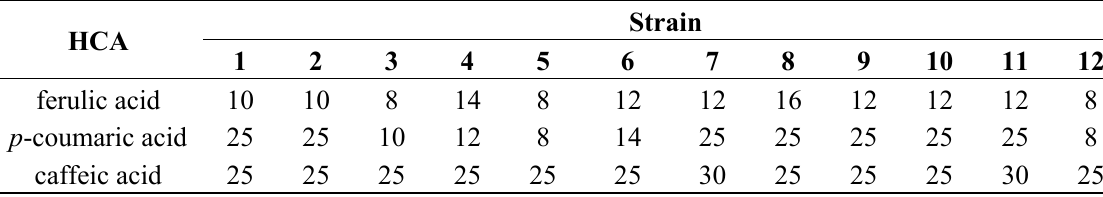
Table 2. Minimum inhibitory concentrations (millimolar) of hydroxycinnamic acids (HCAs) for each